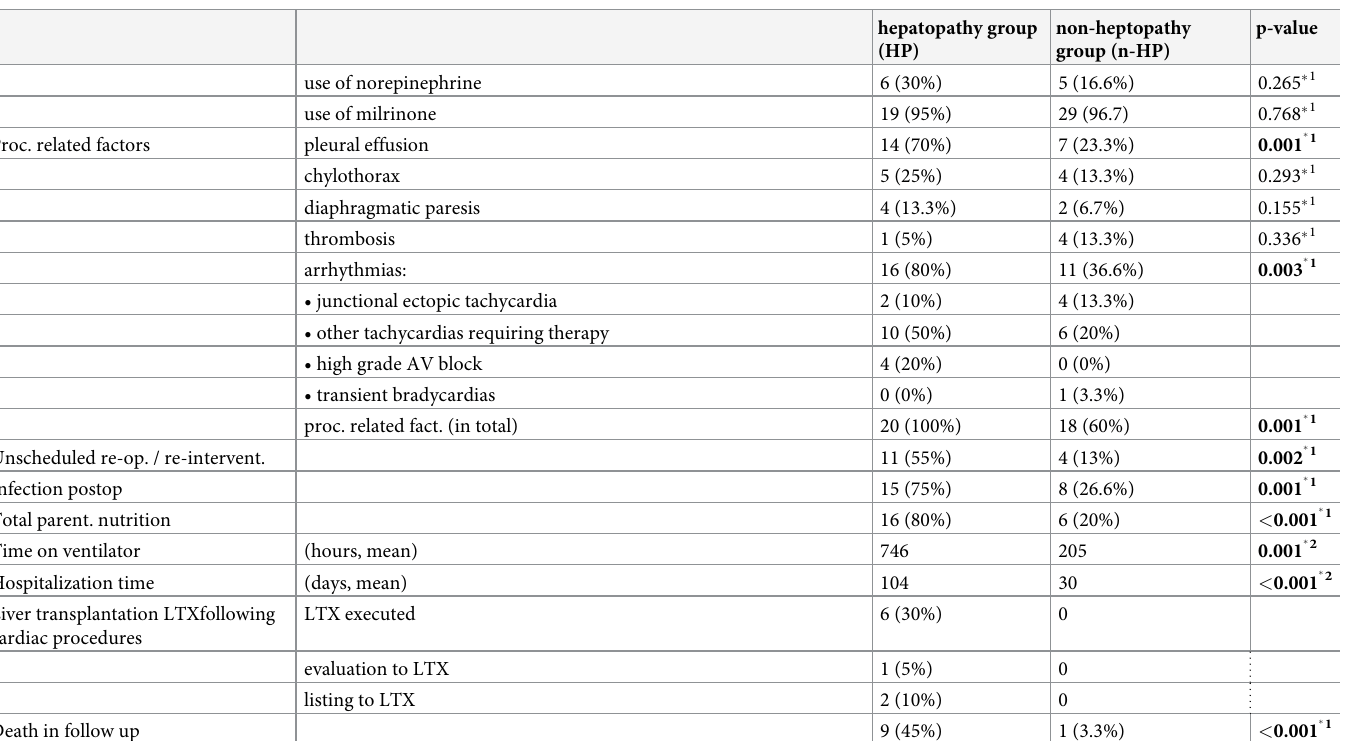
the risk for postoperative hepatopathy significantly. Using multivariate logistic regression (Table 3) postoperative elevated lactate levels (OR 2.25; 0.006), right heart dysfunction (OR 8.98; p = 0.027), unscheduled re-operation or